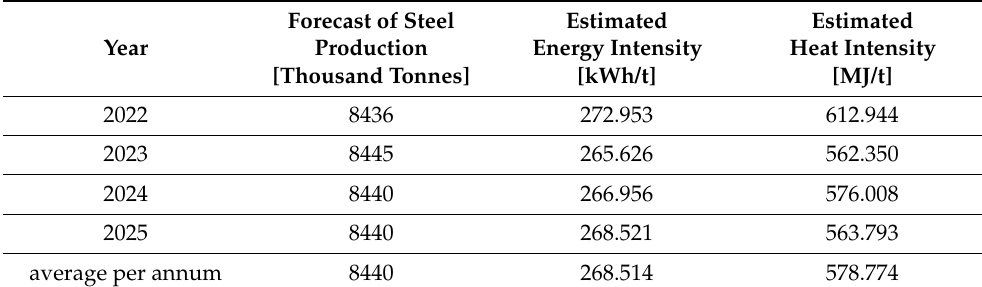
Table 5. Forecasts of energy and heat intensity based on forecasting model used to determine the forecasts of steel production in 2022–2025 (variant 2B).